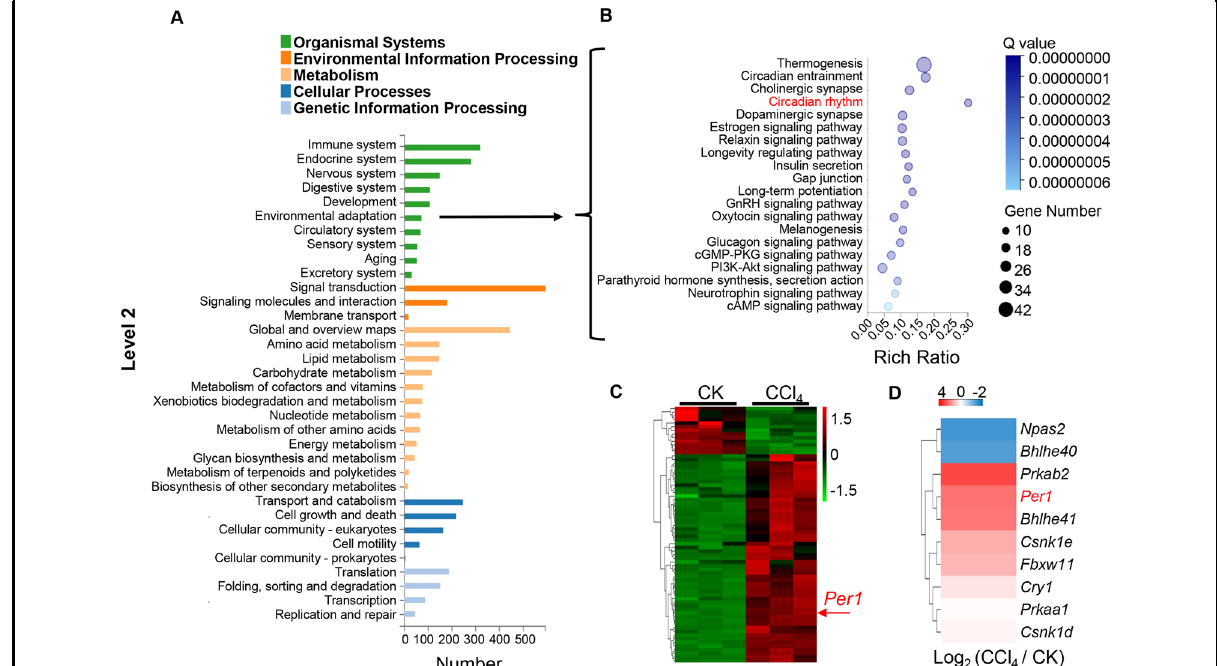
Fig. 1 Per1 mRNA levels were upregulated signi fi cantly in mice exposed to carbon tetrachloride identi fi ed by RNA-Seq analysis. Liver tissues were collected 24 h after a single CCl 4 treatment. Samples were analyzed by RNA-seq and differentially expressed pathways. A Distribution of the level 2 KEGG pathways in both CK and CCl 4 . The bar chart showed the numbers of sequences that were assigned within different pathway categories. B Top 20 pathways in the environmental adaptation from A were shown. C Heat map of 70 DEGs in the environmental adaptation pathway from A . D DEGs in the Circadian rhythm pathway from B were shown. CK: control. N = 3 independent biological replicates per